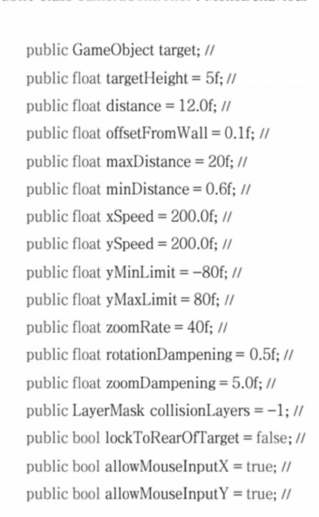
Figure 13. The camera Controller controls the moving speed variable part of the code.